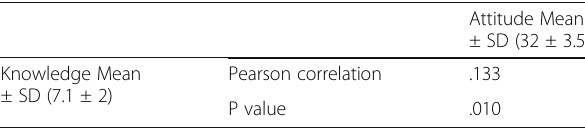
Table 4 Correlation between participants ’ knowledge and